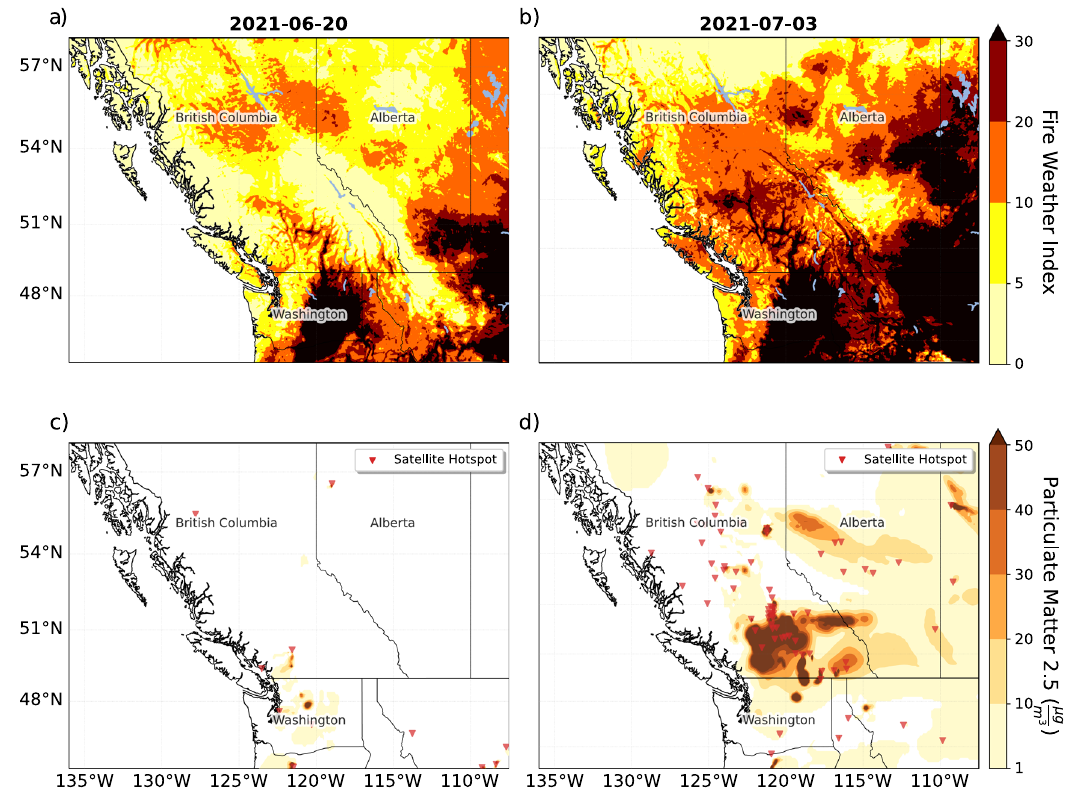
Fig. 7 | Heatwave impacts on wild fi re conditions. Model estimated Fire Weather Index (FWI; a , b ) and smoke concentration and satellite hotspots ( c , d ) for pre- heatwaveconditionson20June( a , c )andpost-heatwaveconditionson3July( b , d ).